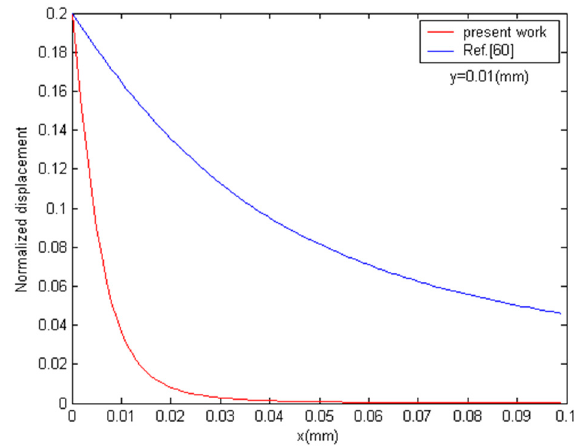
Figure 5. Variations of 3